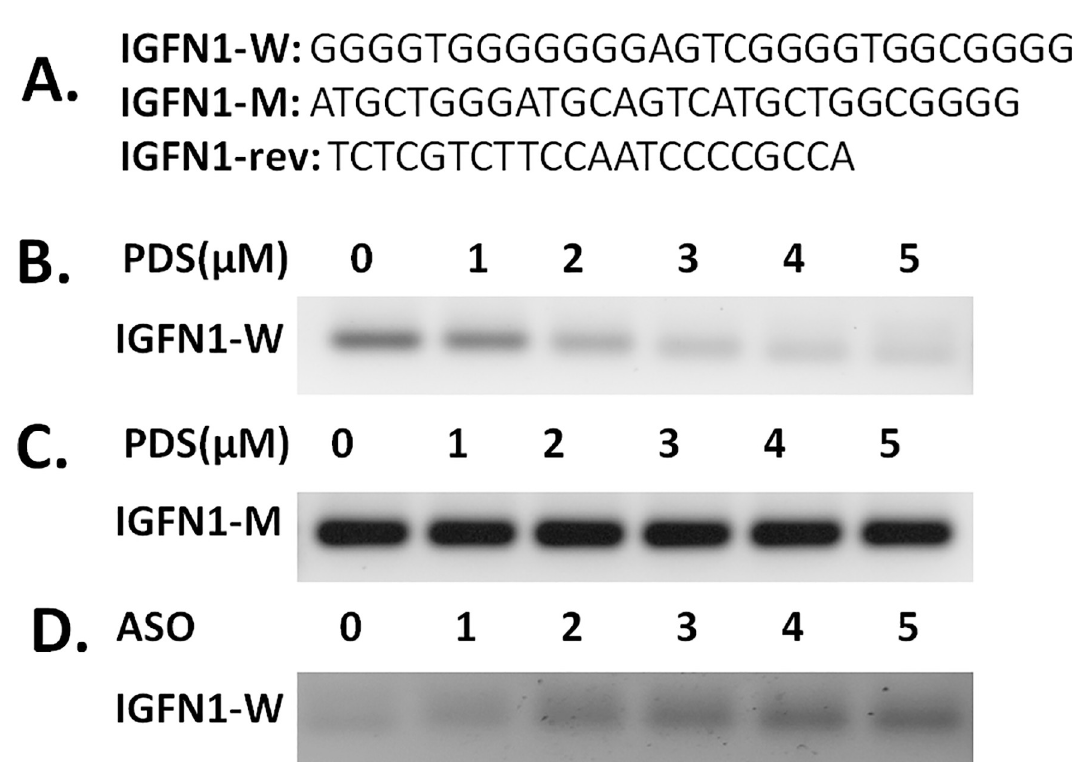
Fig 5. PCR stop assay. Oligo sequence of IGFN1 wild type(IGFN1-W), mutant type(IGFN1-M) and partially complementary (IGFN1-rev) oligo used in PCR stop assay, overlapping complementary last G-repeat sequence is underlined (A); Gel picture showing the inhibition of Taq DNA polymerase extension leading to the PCR stop at 0, 1, 2, 3, 4, 5 μ M PDS concentration in IGFN1-W (B) and IGFN1-M oligo (C); PCR stoppage by G-quadruplex stabilization in presence of 4 μ M PDS was rescued in presence of different molar concentration (0, 1, 2, 3, 4, 5 times) of IGFN1-C antisense oligonucleotide (ASO) with respect to molar concentration of IGFN1-W